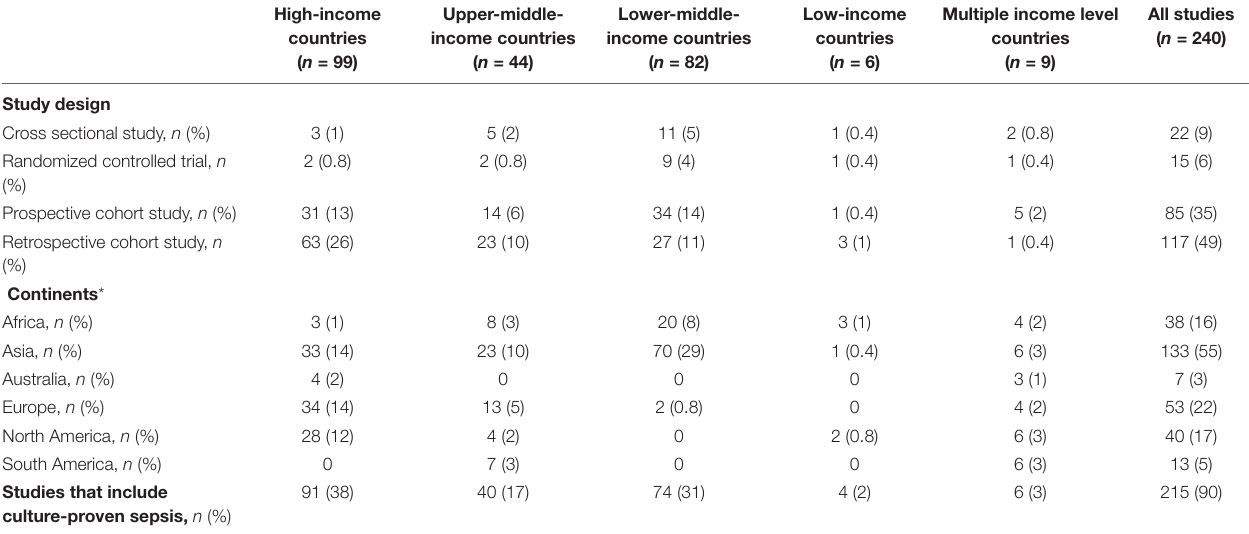
TABLE 1 | Characteristics of